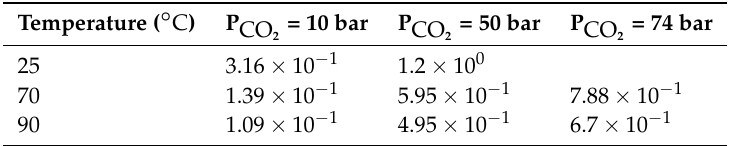
Table 2. Concentration of CO 2 (aq) (mol/(kg water)) at different atmospheric pressure and formation temperature. Reference from